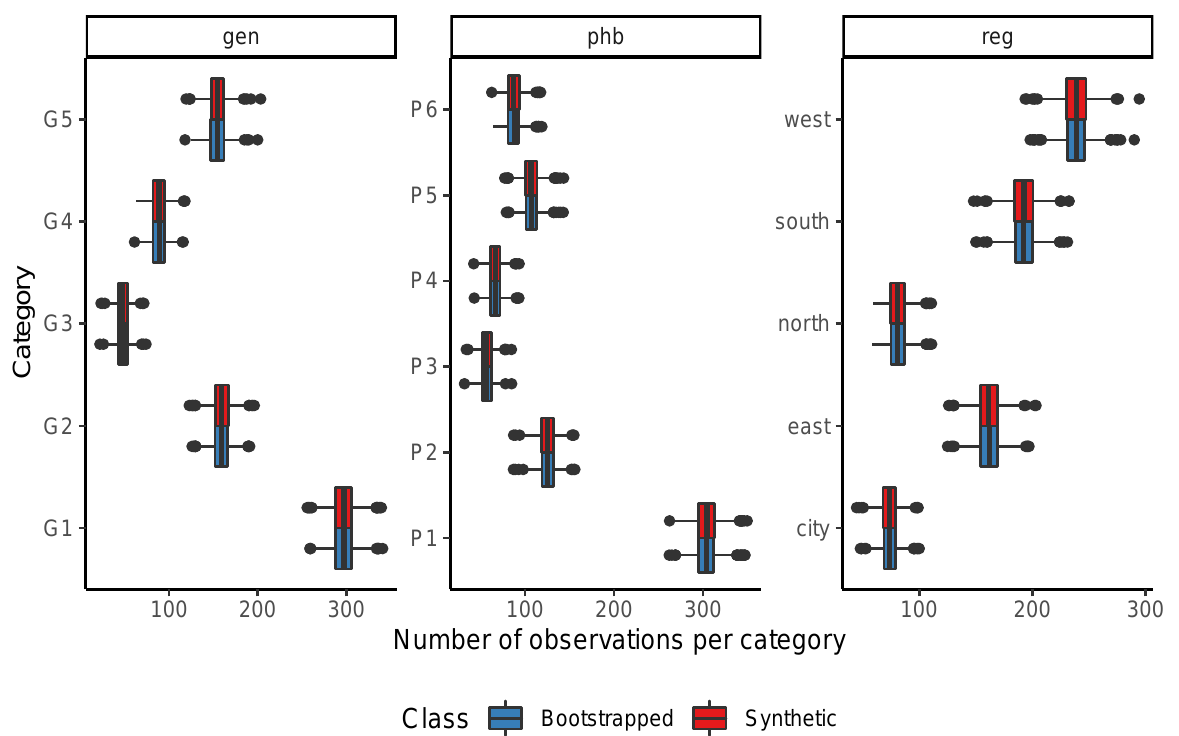
Figure 1. Empirical sampling distribution of the bootstrapped and synthetic means of the continuous variables in the boys data.